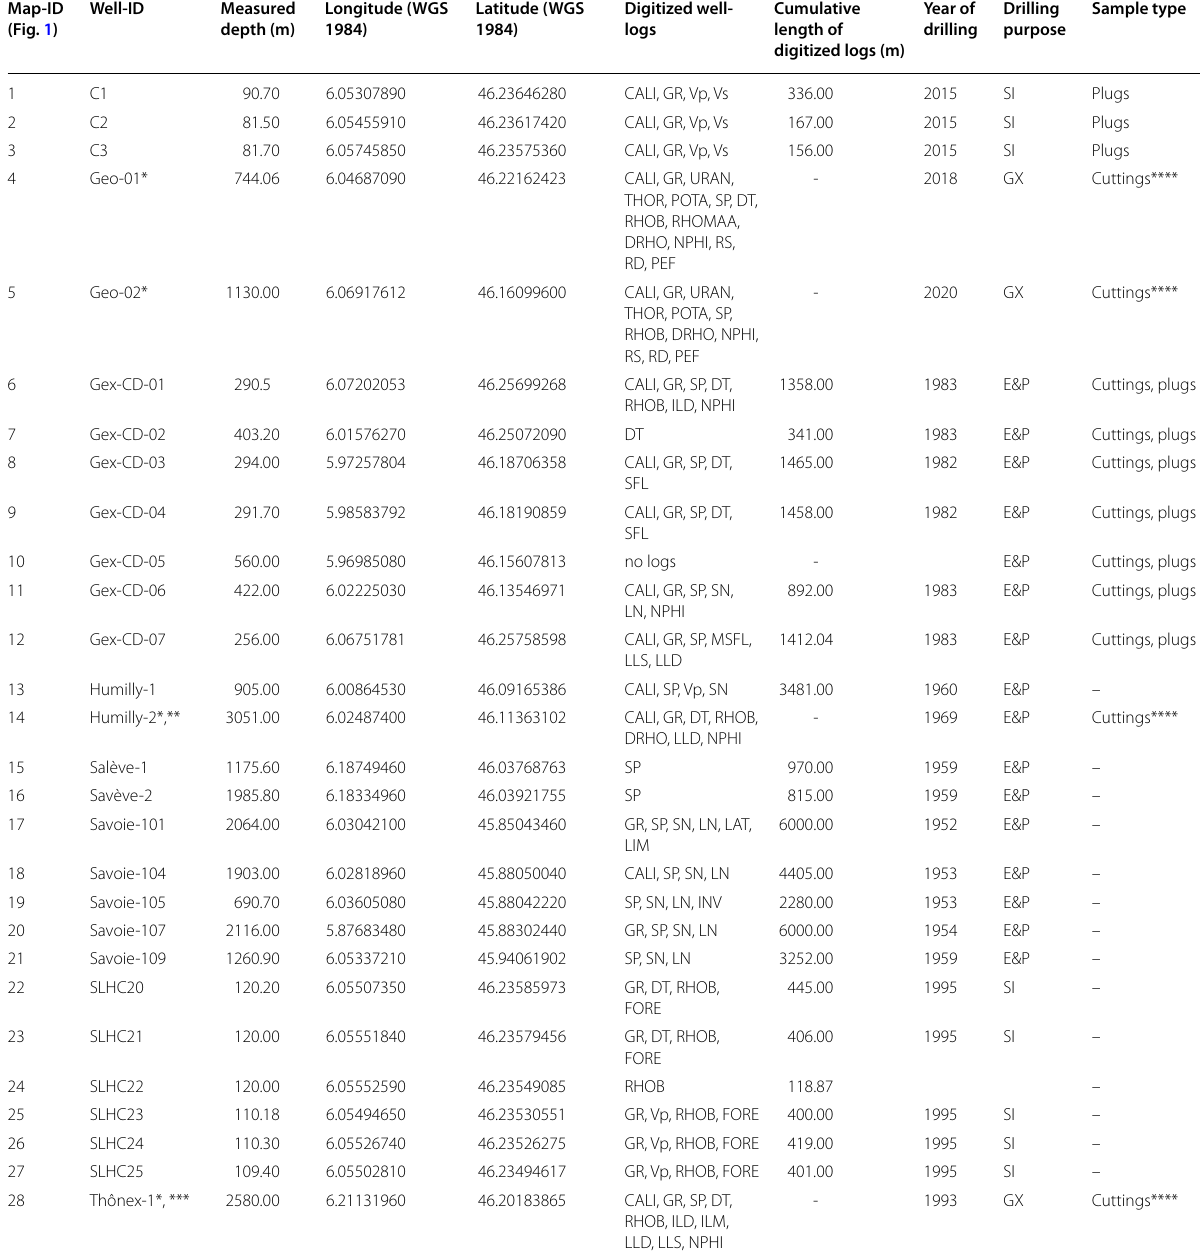
Table 1 List of boreholes containing digitized and analysed geophysical well-logs used for petrophysical calculations and lithotype